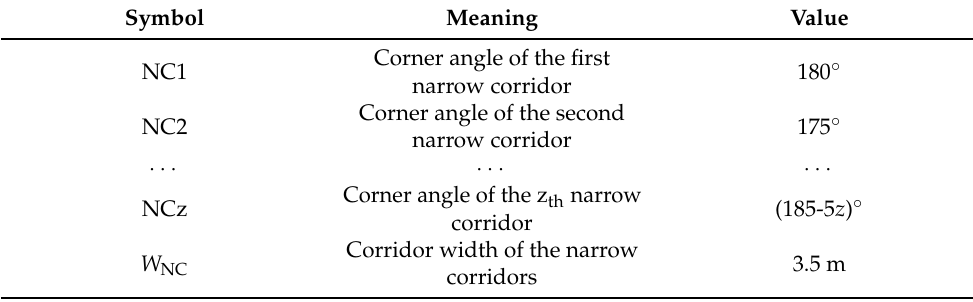
Table 1. Narrow corridor cluster parameters.